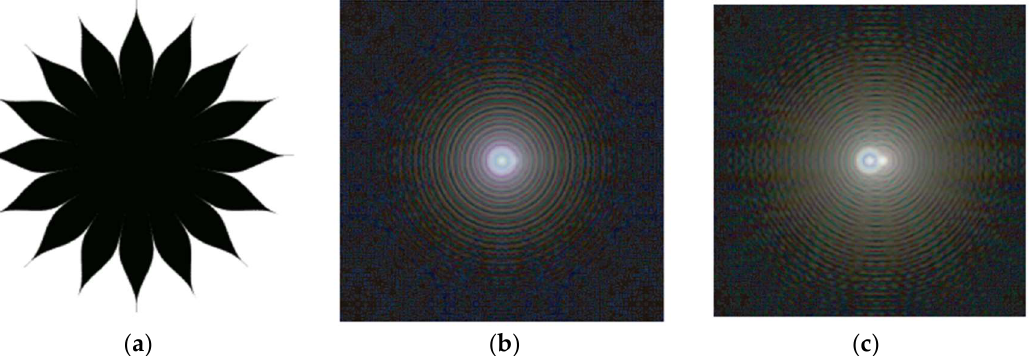
Figure 8. ( a ) The 16-petal starshade corresponding to the optimized solution in [18]; ( b , c ) Simulated images at the telescope’s image plane; RGB colors correspond to wavelengths 1 μm, 0.7 μm and 0.4 μm, respectively. ( b ): Planet at 60 mas. Parameters: R = 22 m, d S-T = 66,000 km; ( c ): Planet at 72 mas. Parameters: R = 25 m, d S-T = 72,000 km.